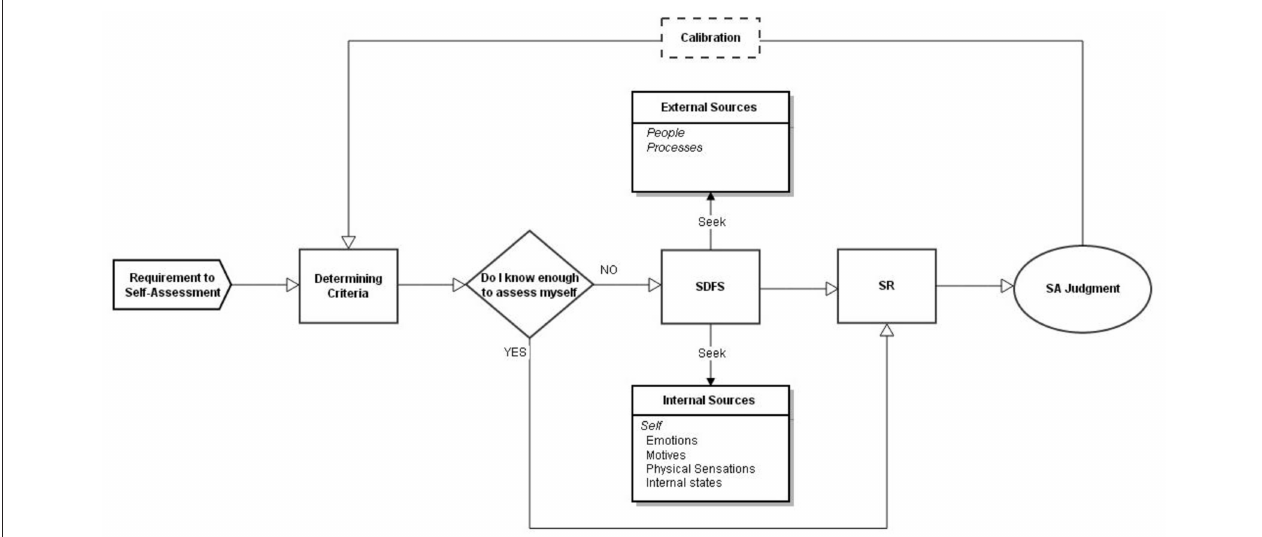
FIGURE 1 | Theoretical framework of the cyclical self-assessment process (Yan and Brown,